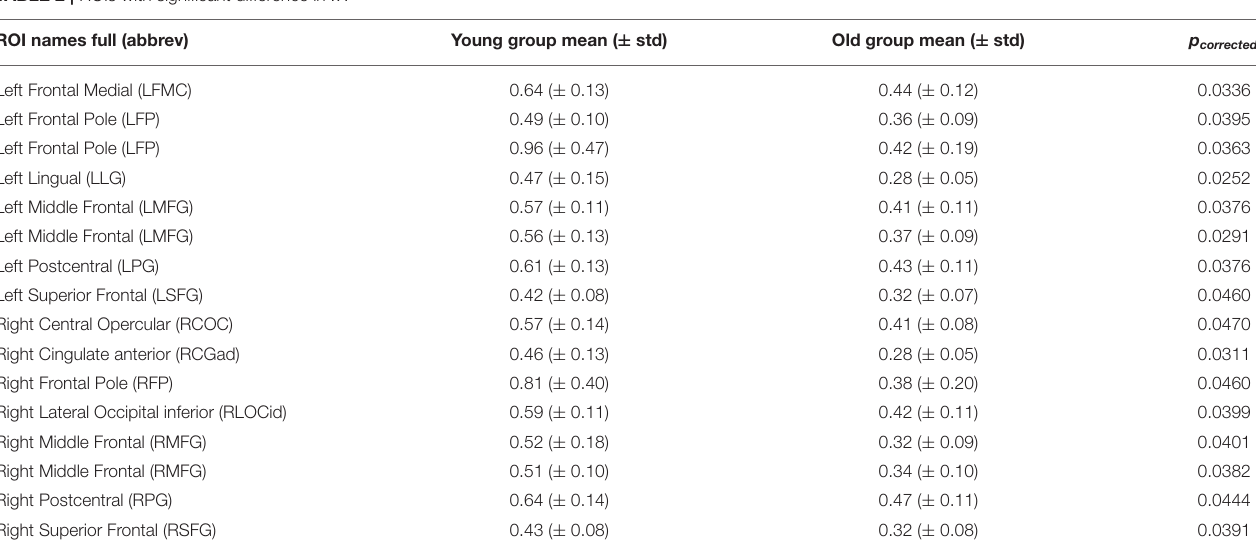
TABLE 2 | ROIs with significant difference in w